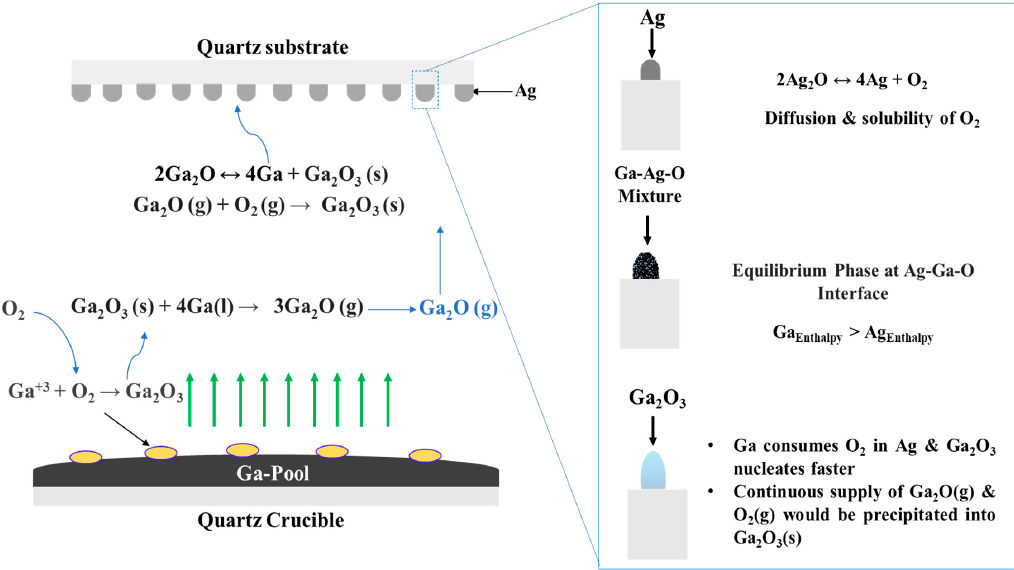
Figure 12. Schematic illustration of the proposed growth mechanism of Ga 2 O 3 on the Ag-patterned quartz surface.